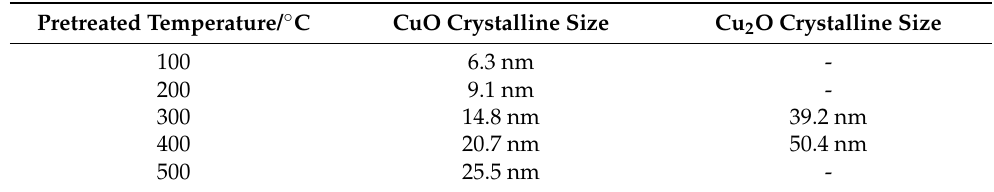
Table 2. The crystalline sizes of CuO and Cu 2 O on the 20% Cu-A-BM samples calcined at different temperatures.